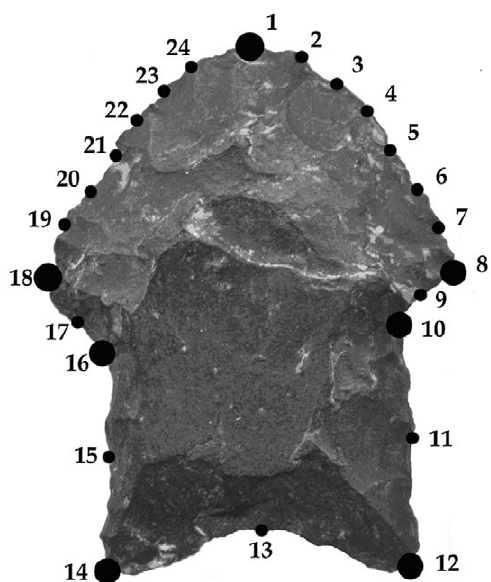
Figure 1. Landmark configuration. Landmarks ( large dots ) and semi-landmarks ( small dots ) used in this